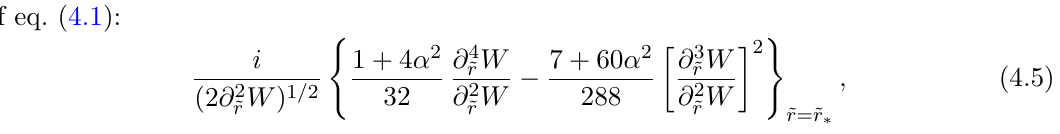
Figure 1 . Plot of the fractional change in position of the GR light ring r a change in angular momentum ‘ . We are considering the change with respect to the (cid:12)ducial value r (3), i.e. we have de(cid:12)ned (cid:1) ; GR (cid:3) light ring in GR depends weakly on the angular momentum number ‘